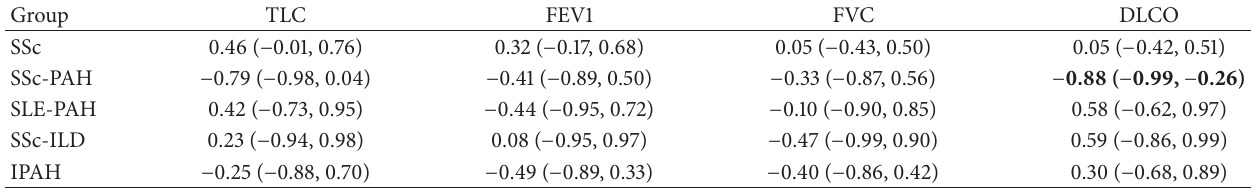
Bold denotes significant correlations.